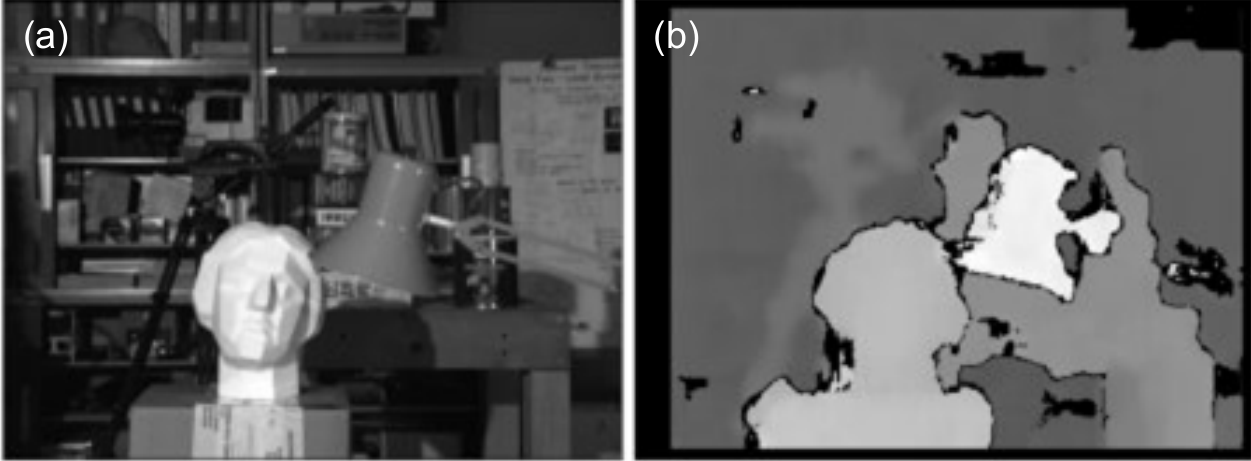
Figure 4. Example of a depth map created using MVS algorithms. Image ( a ) shows the original scene and image and ( b ) the extracted depth map. Lighter shades of gray indicate closer elements, and darker shades are more distant elements. Source: OpenCV Documentation [41].